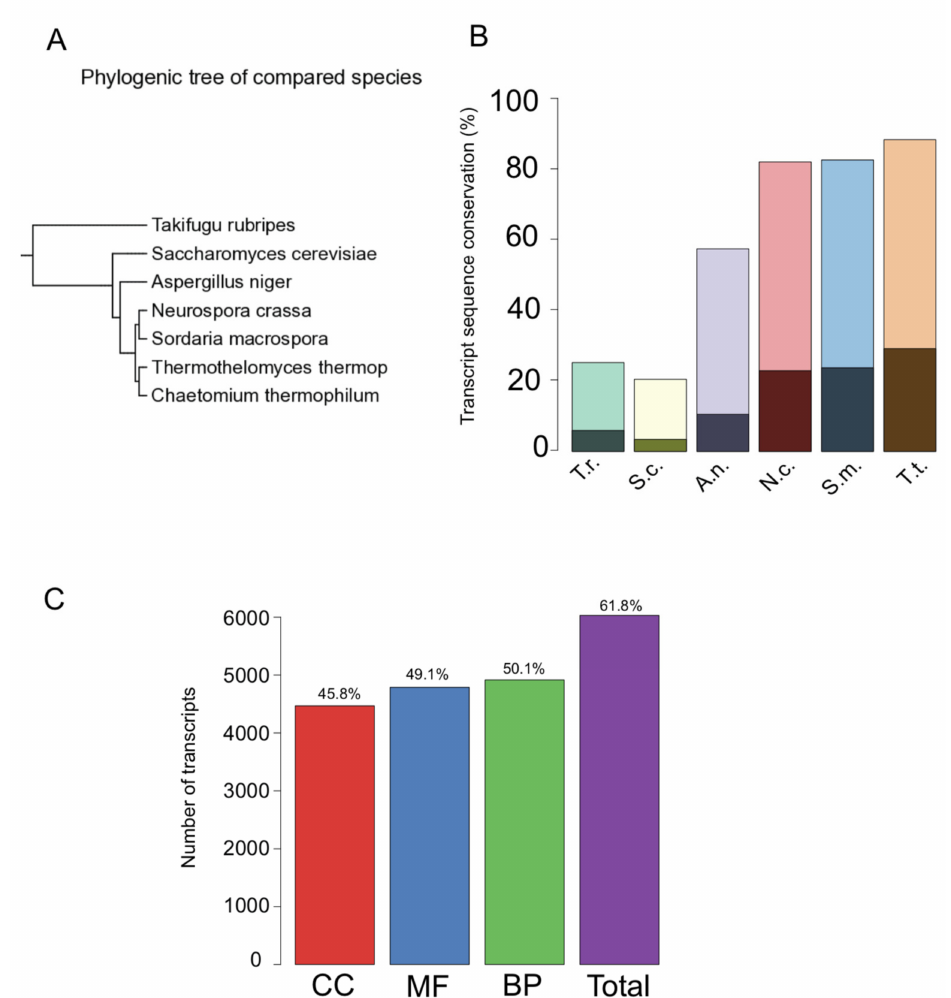
Figure 3. Phylogenetic conservation of coding and noncoding C. chaetomium transcripts. ( A ) Phylogenic tree of six indicated species. ( B ) Double bar graph representing the sequence similarity of C. thermophilum transcripts with six indicated species. Light bars correspond to the percentage of similar coding transcripts. The dark bars in front correspond to the percentage of noncoding transcripts. ( C ) Number of transcripts associated with the GO annotations “biological process” (BP), “molecular function” (MF), and “cellular compartment” (CC). The right bar indicates the total number of transcripts associated with at least one GO term. The percentage of transcripts associated with the respective GO terms is indicated. Note that a given transcript can be associated with more than one GO